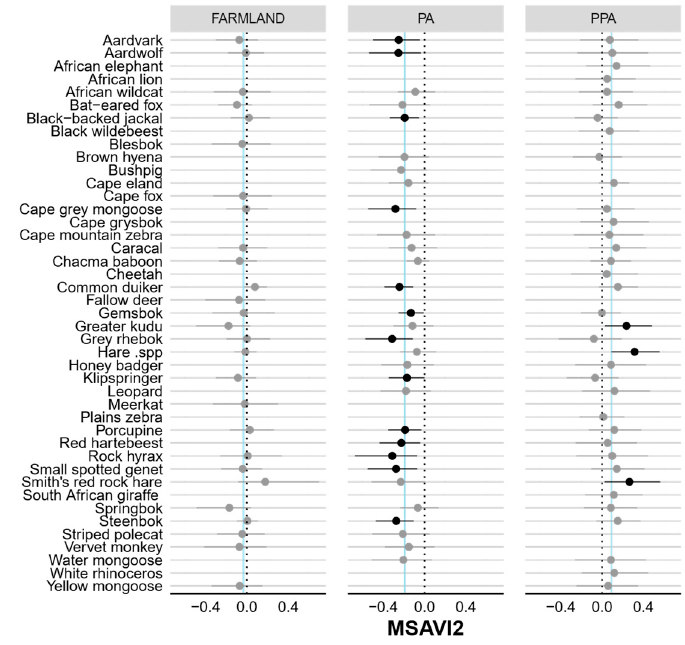
Figure A2. Caterpillar plots showing posterior means of detection (P) probabilities per species, as estimated under a hierarchical multi-species occupancy model, in farmland, PA and PPA. Error bars represent 95% Bayesian credible intervals.